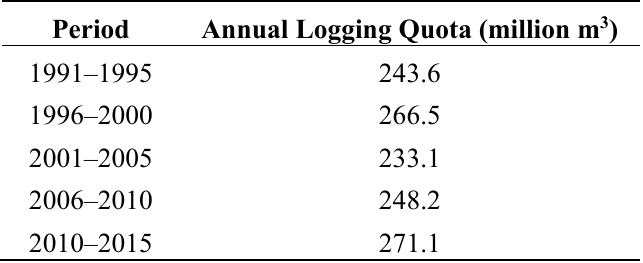
Table 1. Annual logging quota